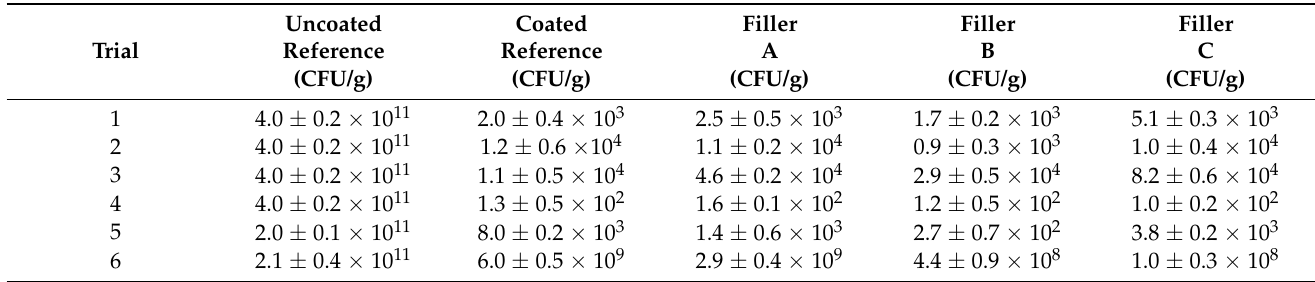
Table 5. Evaluation of the effect of filler solutions on the viability of coated and uncoated L. plantarum after 6 months.